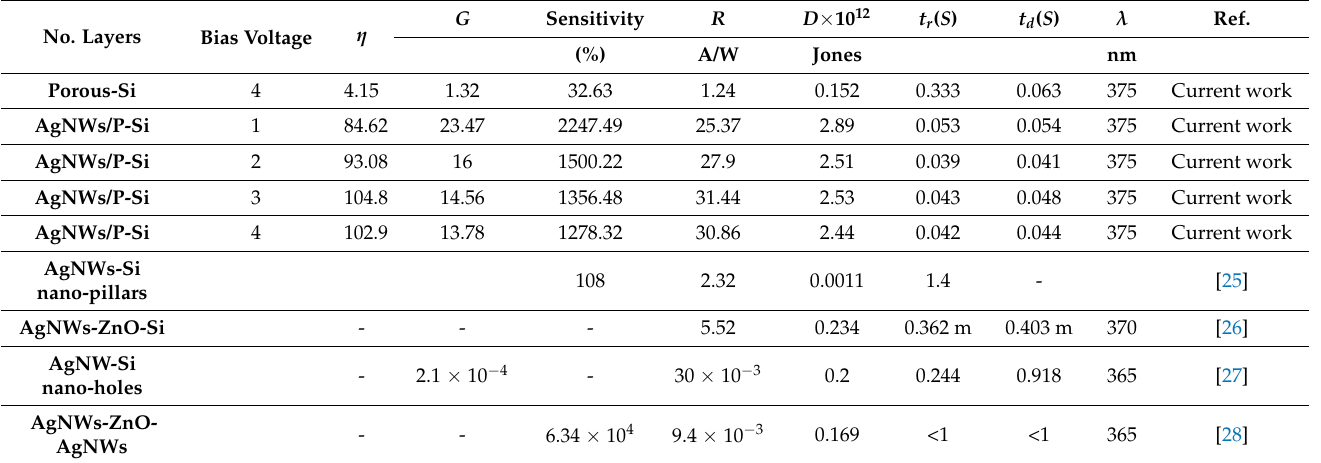
Table 1. Key parameters of AgNW-based photosensors in a comparison between the current work and the previous studies.